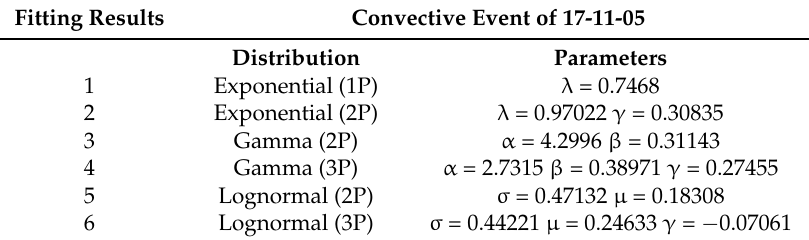
Table 2. Fitting results for the event of 17/11/2005.